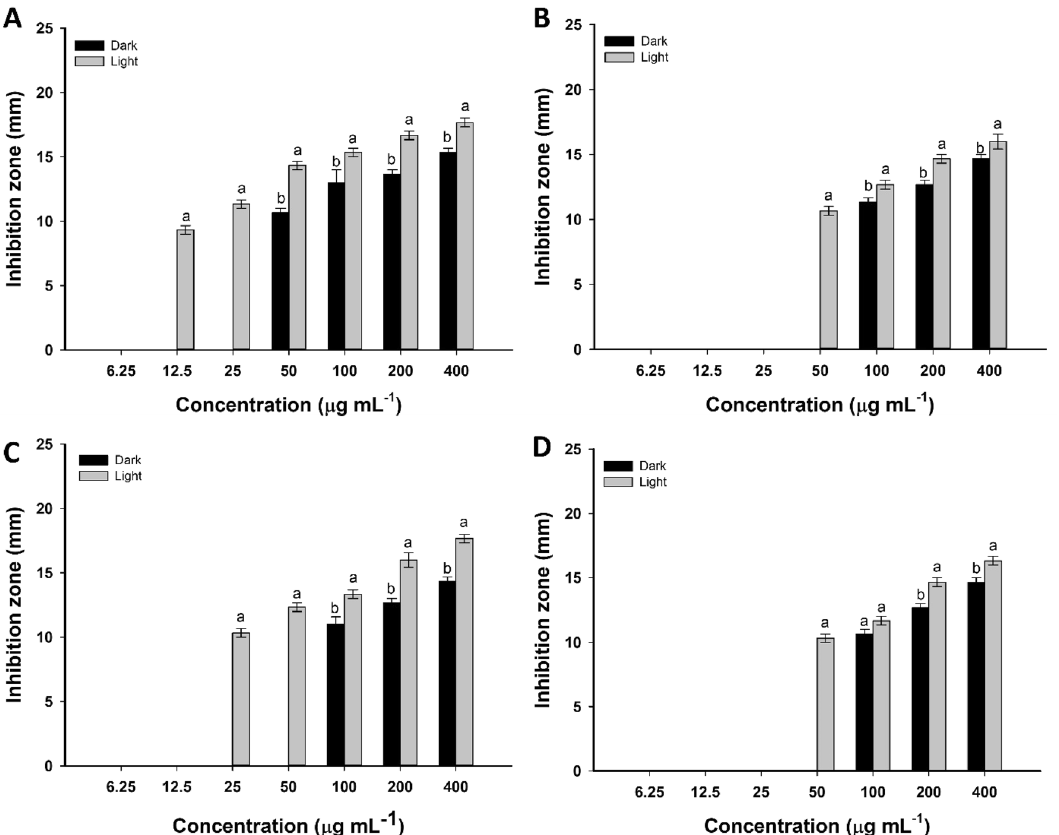
Figure 3. Antibacterial activity of green synthesized Se-NPs against different Gram-positive and Gram- negative bacteria after incubation under dark and light conditions. Bacillus subtilis ( A ); Staphylococcus aureus ( B ); Pseudomonas aeruginosa ( C ) ; and Escherichia coli ( D ) . Data are statistically different at p ≤ 0.05 by Tukey’s test, ( n = 3); error bars are based on three independent experiments (means ± SD). Different letters at the same concentration refer to the data that are significantly